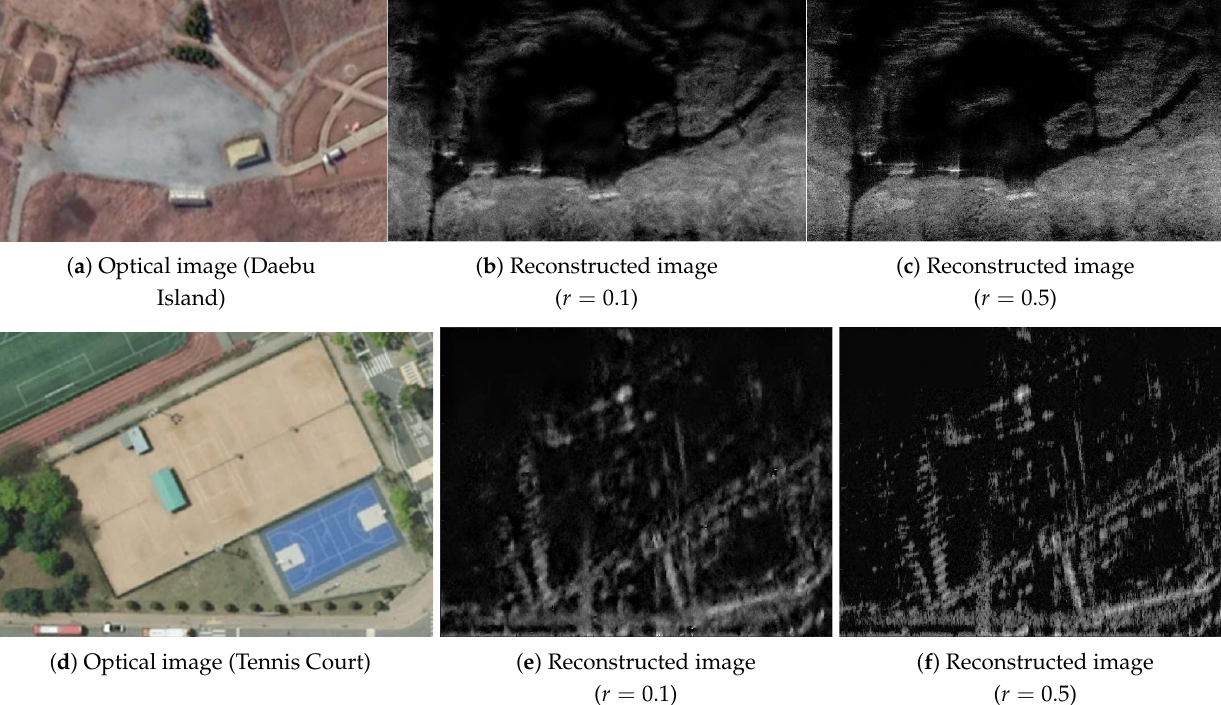
Figure 10. SAR images reconstructed by the proposed clustered BCS method. ( a , d ) denote the optical satellite images of test locations in Daebu Island and Tennis Court in Korea Aerospace University,